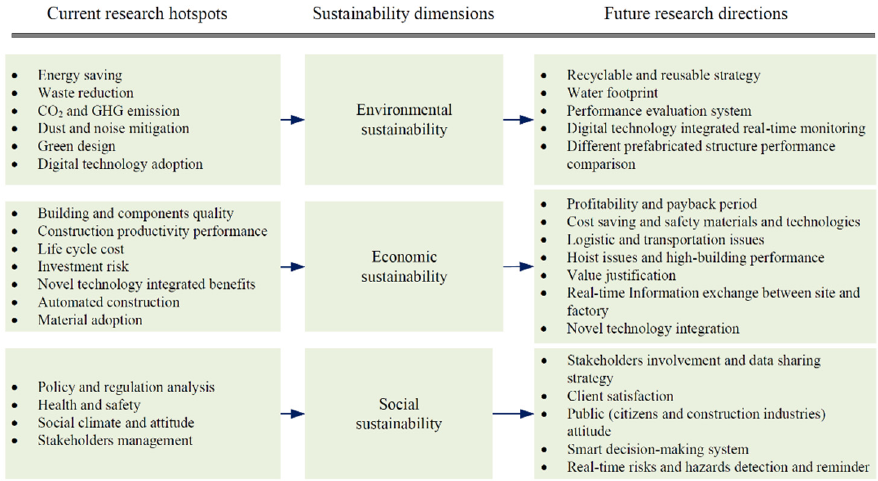
Figure 3. Current research domains and future directions of prefabrication towards sustainability.